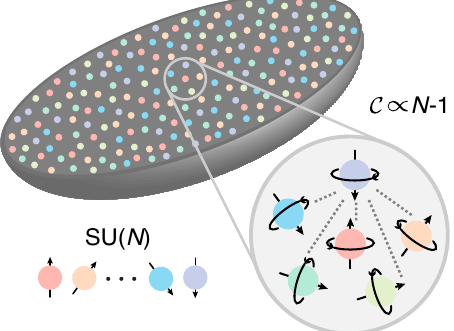
FIG. 1. Illustration of s -wave contacts in SU ð N Þ fermions with tunable spin. Arrows with different colors and orientations denote the different nuclear spin states as large as N ¼ 6 . Dashed lines represent pairs formed by two particles with different spins. Each pair contributes equally to the contact, which leads to C ∝ N − 1